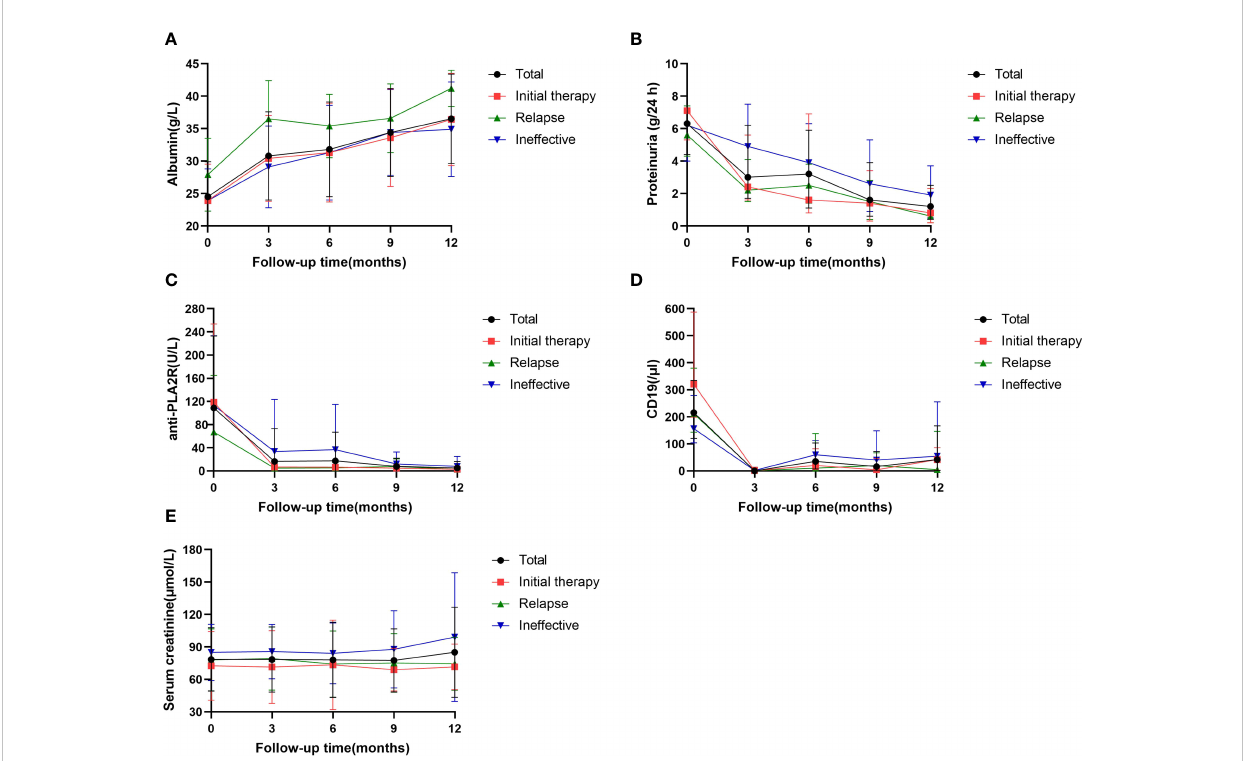
FIGURE 3 Serial levels of albumin (A) , proteinuria (B) , anti-PLA2R antibody (C) , the absolute values of CD19 (D) ana serum creatinine (A) after rituximab treatment in patients who had been followed up for 12 months. Data are presented as the medians (interquartile range) over time (B, D) or mean ± SD (A, C, E)